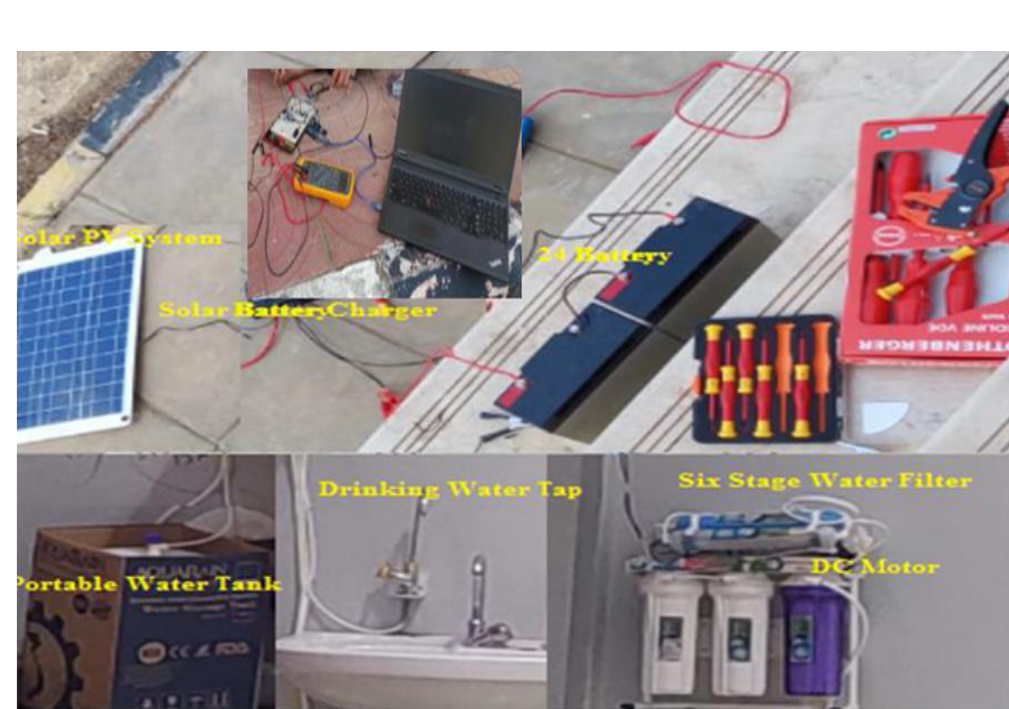
Figure 6. A hardware model of solar photovoltaic based portable water filter.